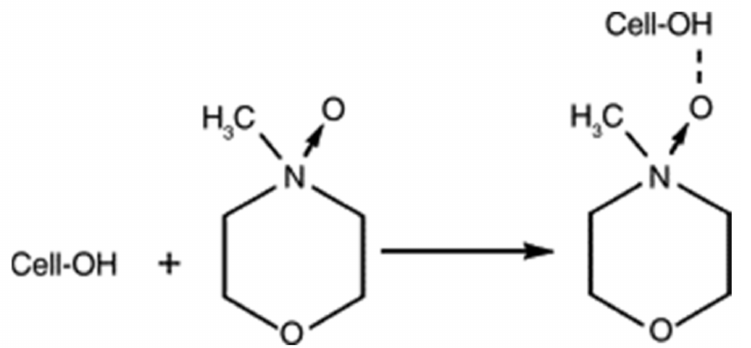
Figure 5. Typical mechanisms of cellulose dissolution in NMMO. Reprinted from [134] with permis- sion from Elsevier ©